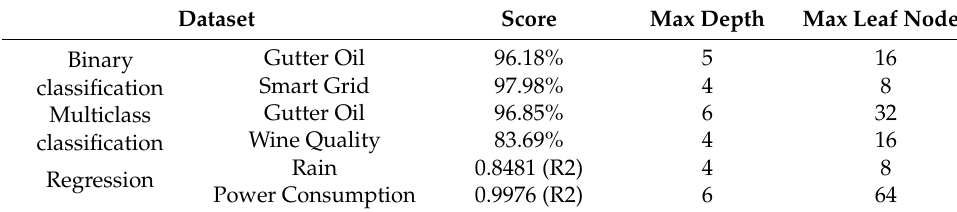
Table 9. The highest-scoring parameters of DT obtained in different